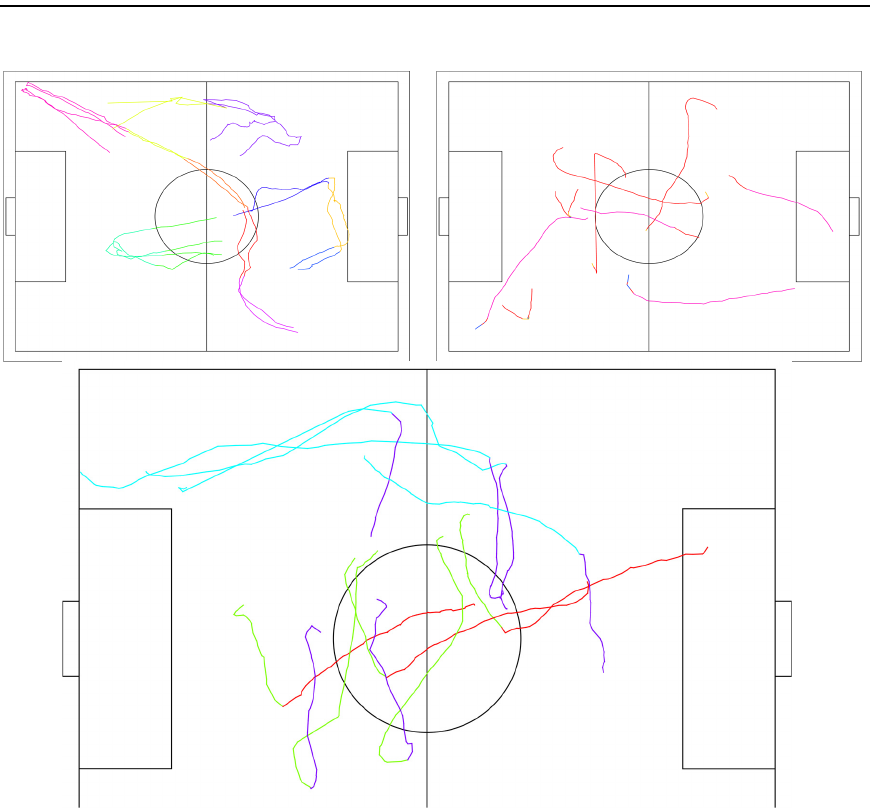
Figure 9. Some resulting movement patterns: ( Top left ) no invariances: spatially overlapping trajectories are found. ( Top right ) Translation and rotation invariance: the trajectories belonging to the same pattern are shifted and rotated. ( Bottom ) Translation invariance: in this case only shifts are allowed. The colors symbolize different cluster assignments of each single movement/sequence element.